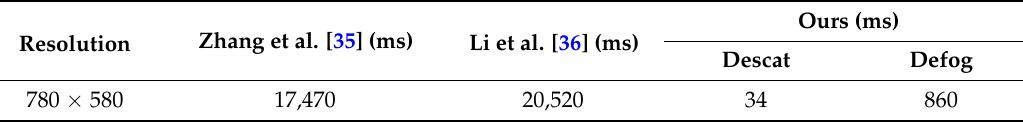
Table 4. Processing time.